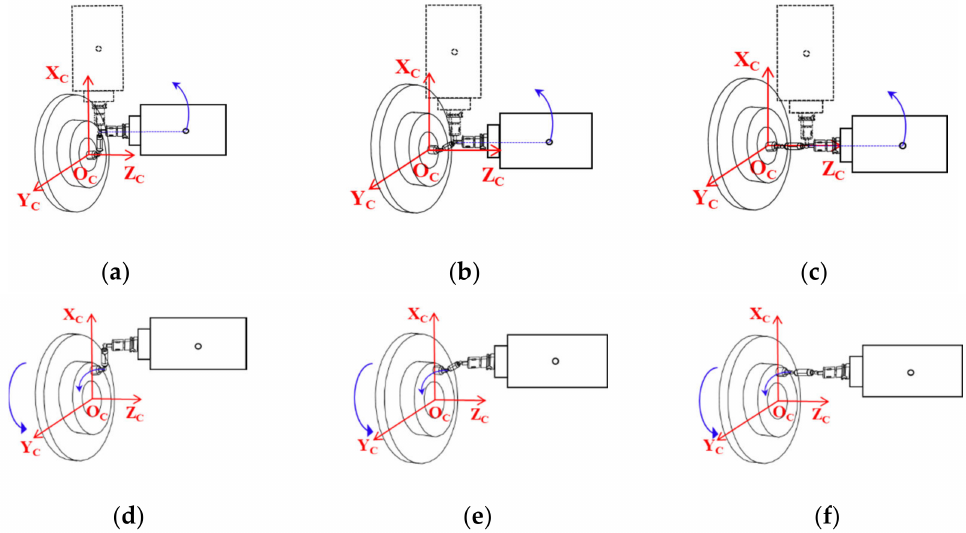
Figure 5. ( a ) B axis X-direction measurement; ( b ) B axis Y-direction measurement; ( c ) B axis Z-direction measurement; ( d ) C axis X-direction measurement; ( e ) C axis Y-direction measurement; ( f ) C axis Z-direction